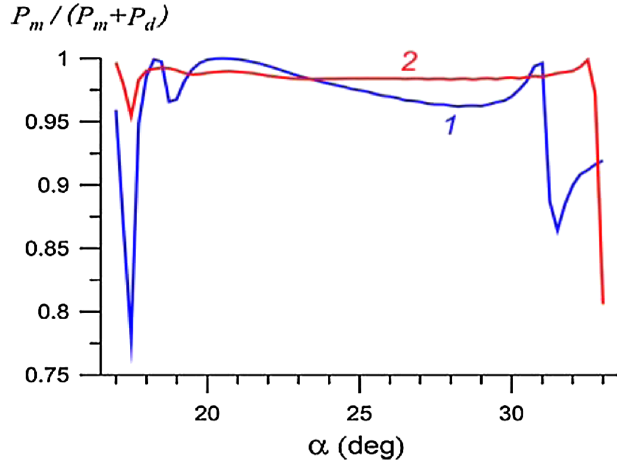
FIG. 4. (Color) Ratio of reflection of a plane wave into a mirror beam is shown as a function of the angle of incidence for quartz and composite gratings (1 and 2, respectively). Here, P power in the diffraction beam and P